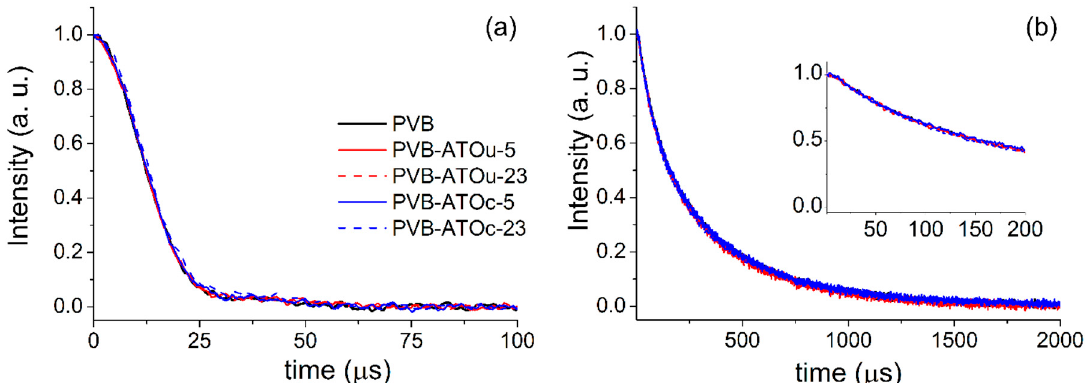
Figure 8. Comparison of the free induction decays (FIDs) exhibited by PVB and by the indicated PVB-ATO composites at 30 ( a ) and 100 ° C ( b ). The FIDs were recorded by applying the solid echo pulse sequence. t indicates the time elapsed from the echo maximum. The signal intensities were scaled to the same value at t = 0 in order to facilitate the comparison of the decay rates.